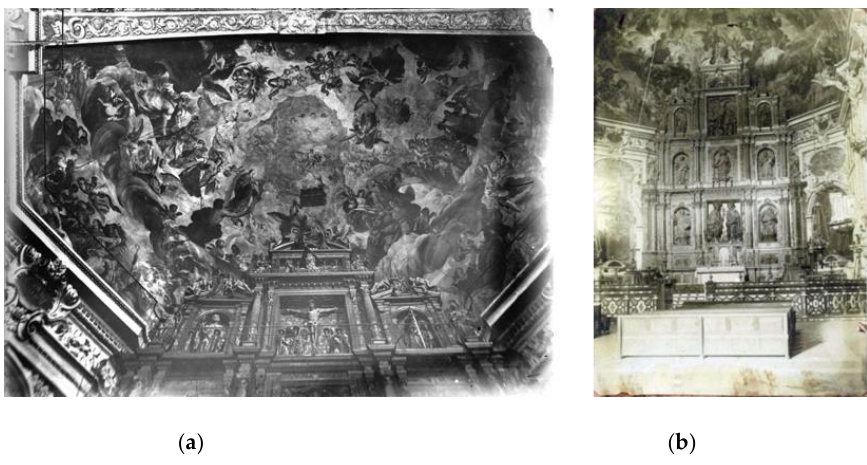
Figure 2. ( a ) Original photograph (nadir). ( b ) Original photograph